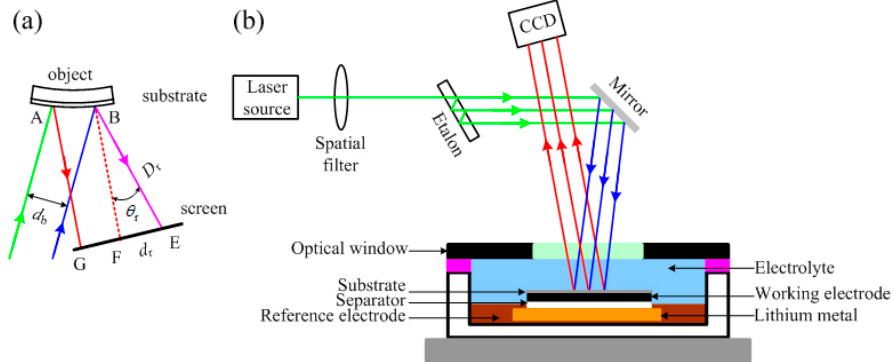
Figure 3. Schematic representation of MOSS technique: ( a ) laser beams on the substrate of an object [30]; and ( b ) typical experimental setup [31,32]. and ( b ) typical experimental setup